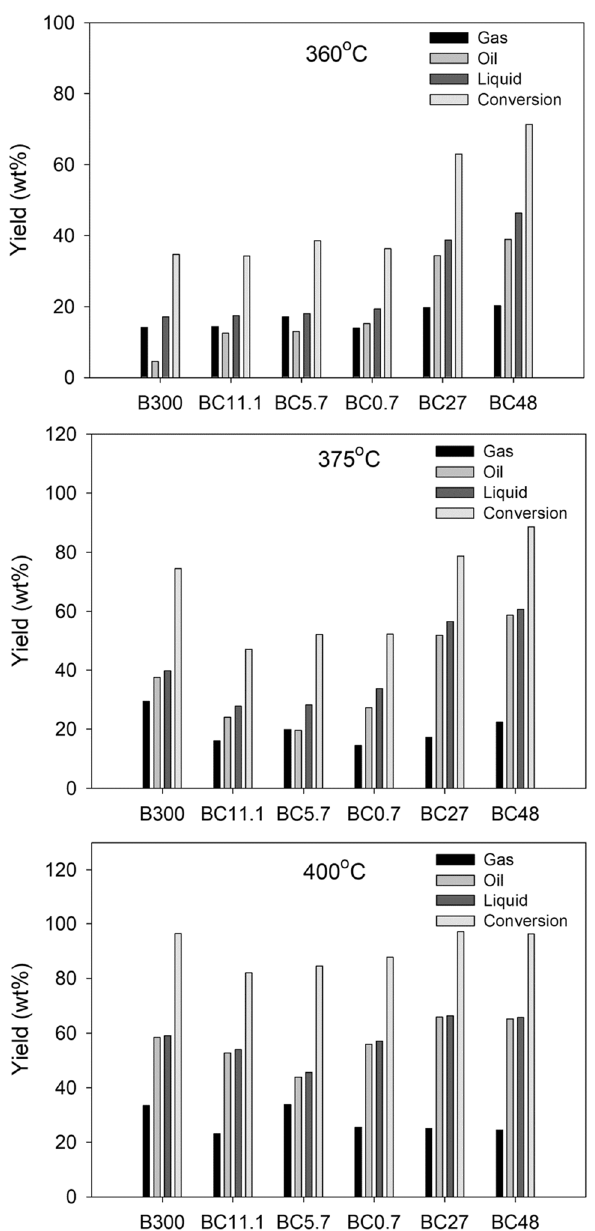
Fig. 9 Results of the catalytic hydroconversion reactions of model plastic mixture over different catalysts. 500 ml autoclave reactor, 20 bar initial cold hydrogen pressure, 60 min residence time, and 20:1 feed-to-catalyst ratio (by